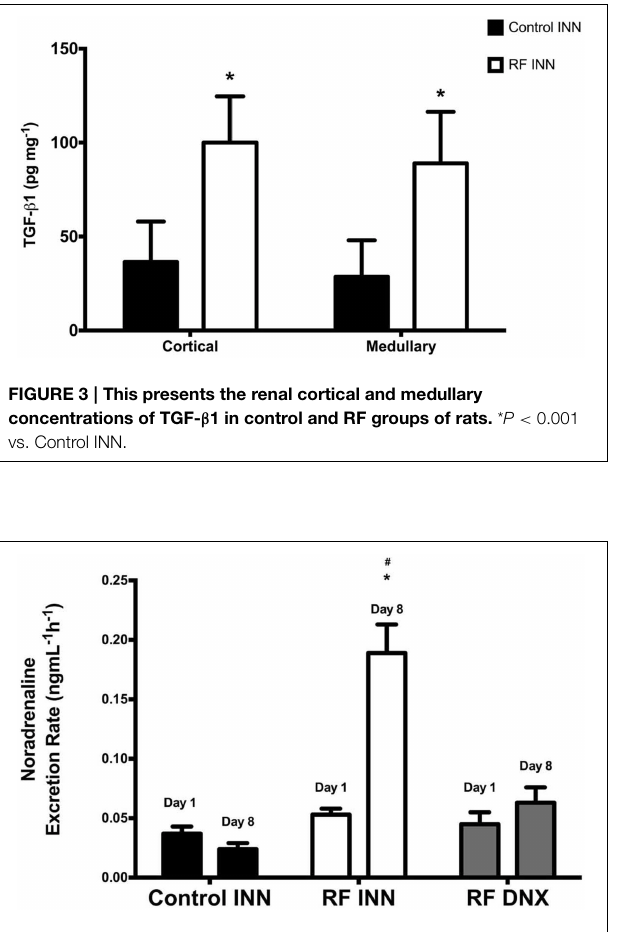
A1,therangeofthecurve;A2,theslopeorsensitivityofthecurve;A3,themid-pointblood pressure;andA4,theminimumpointtowhichtheRSNAcouldbedriveninallexperimental groups. Renal failure (RF) and control rats, with (DNX) or without (INN) renal denervation. Statistical analysis was performed using Two-Way ANOVA followed by Tukey’s post hoc test. Data presented as mean SEM. (n = 12 for control and n = 8 for RF groups). * P < 0.05 vs. control INN; * P < 0.005 vs. control # P < 0.05 vs. RF DNX.